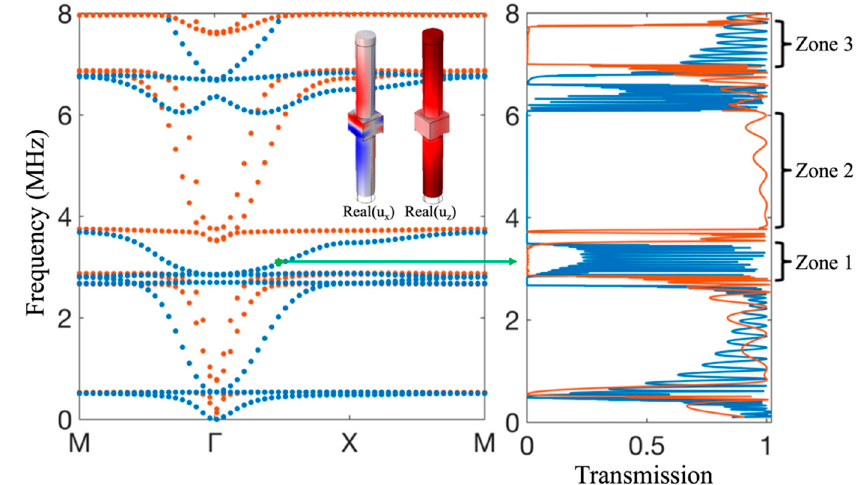
Figure 2. Left panel: Dispersion curves of the symmetric-sided pillared meta-plate along the first irreducible Brillouin zone. The orange and blue bands represent the symmetric and antisymmetric Lamb modes with respect to the middle plane of the plate, respectively. Right panel: Transmission spectra of A 0 (blue) and S 0 (orange) Lamb waves across 15 symmetric-sided unit cells along the Г X direction (see the inset). The wave propagation in not allowed for the S 0 Lamb wave in Frequency Zone 1 (2.9–3.5 MHz) and Zone 3 (7–7.7 MHz), and for A 0 Lamb wave in Frequency Zone 2 (3.8–6 MHz), which match well with the bandgaps of corresponding symmetries. The real parts of u x and u z of the antisymmetric eigenstate at the green dot in the dispersion curves are plotted as the insets, where the red and blue colors mean positive and negative values, respectively.